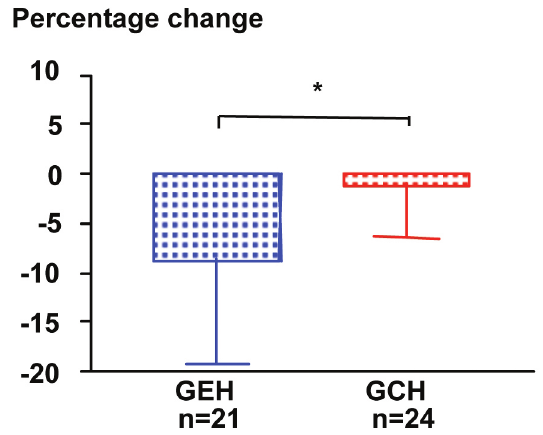
FIGURE 1 - Percentage change ± SD in systolic arterial pressure between time 0 and the arithmetic mean of measures after 120, 180 and 270 days in the hypertensive experimental group (EGH) and hypertensive control group (CGH). *p=0.0005. EGH n=21 (21 patients in EG with SAP above 140 mmHg on the 1st AP measurement); CGH n=24 (24 patients in CG with SAP above 140 mmHg on the 1st AP measure).